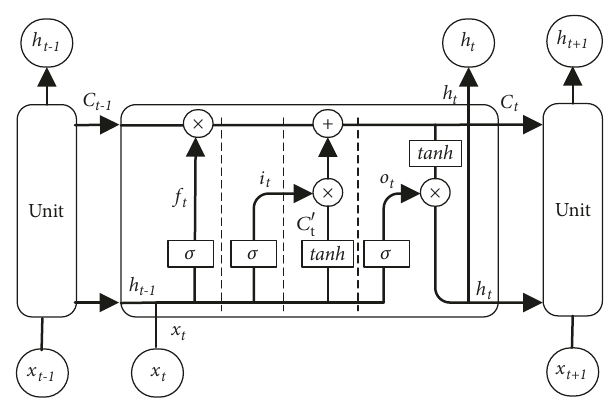
Figure 2: The repeating unit in LSTM